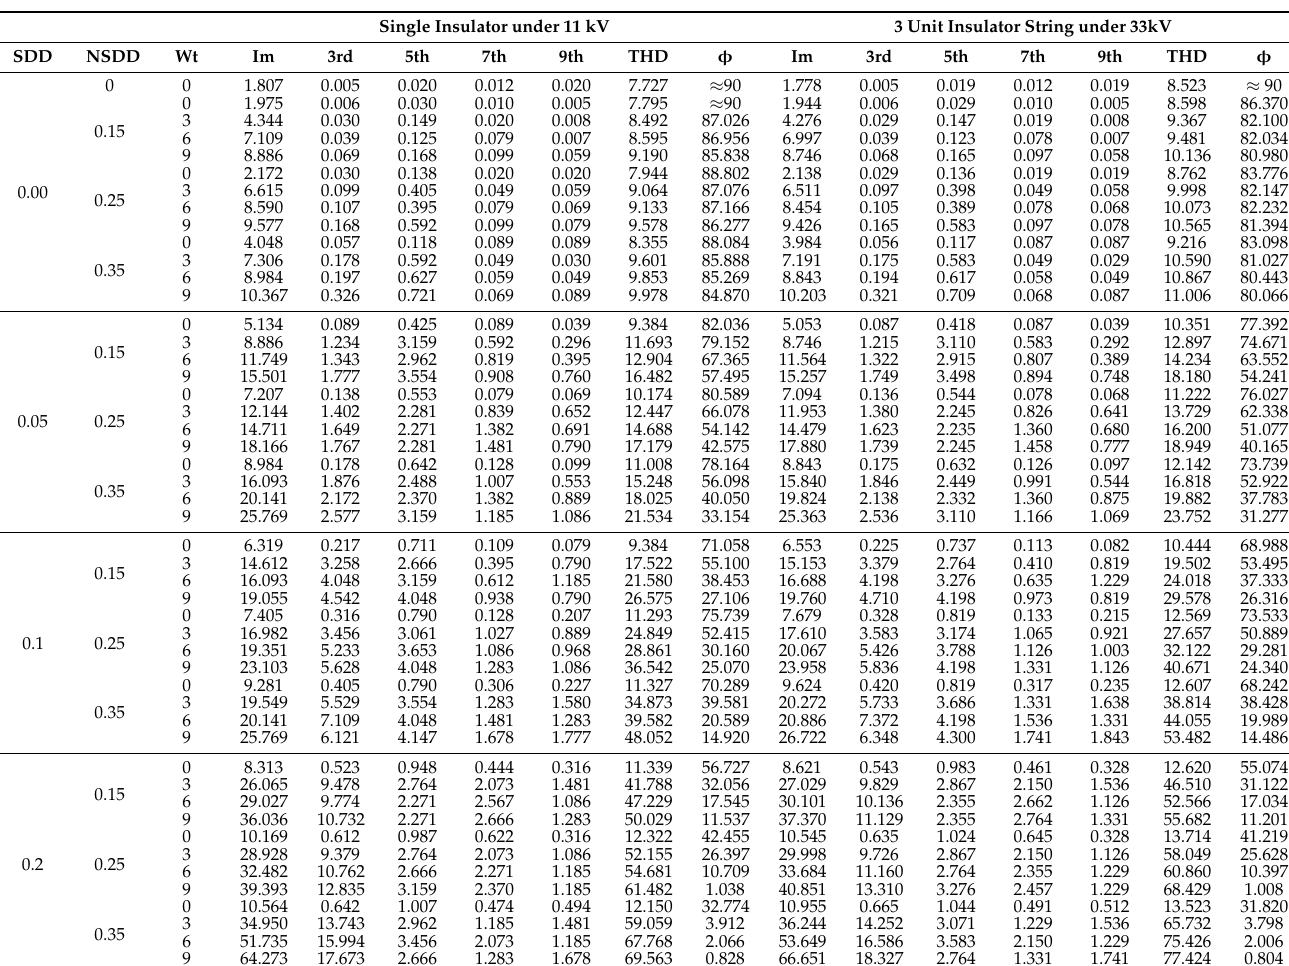
Table 3. LC characteristics for insulators under different contamination degree for uniform